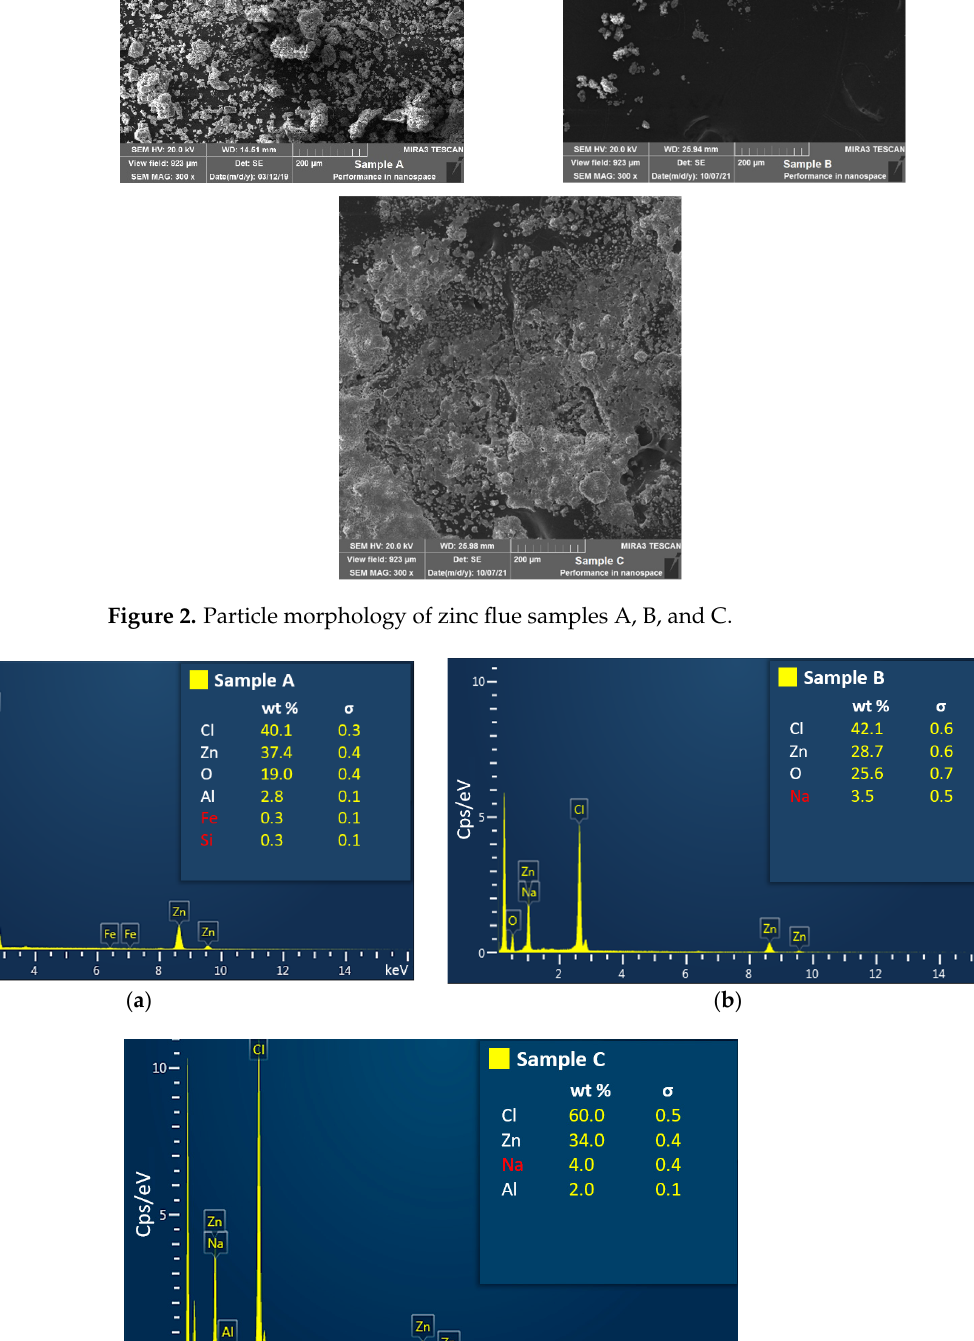
Figure 3. EDS analysis of the Zn flue dust ( a ) sample A, ( b ) sample B, and ( c ) sample C.